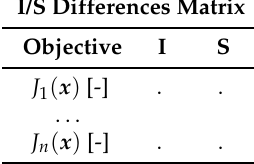
Table 3. Matrix with (in)significant differences. Significant (S) and Insignificant (I) differences for each design objectives are